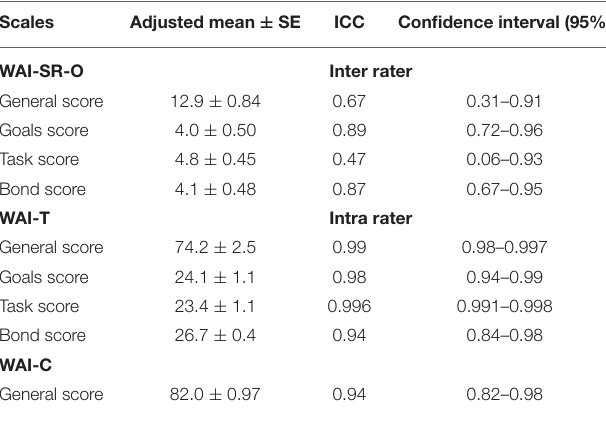
TABLE 2 | Adjusted mean, intraclass correlation coefficient, and confidence interval of the WAI-SR-O, WAI-T, and WAI-C measurements.